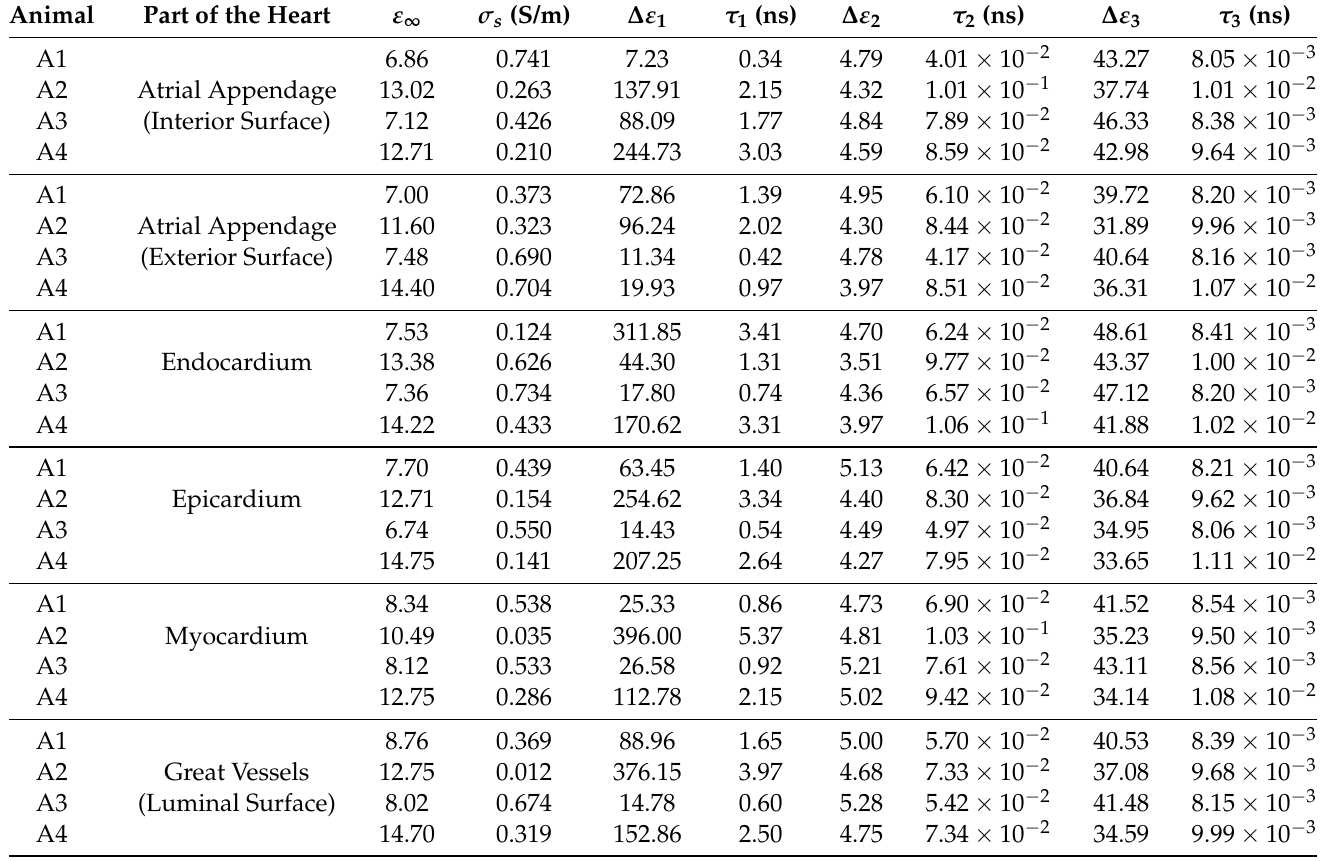
Table 3. Three-pole Debye model parameters fitted to the mean permittivity of measurements on different parts of the heart. Each part was measured on four different hearts and is therefore represented by four sets of Debye model parameters. The model parameters for A1 and A3 are verified at frequencies from 500 MHz to 20 GHz. The parameters for A2 and A4 are verified at frequency range from 500 MHz to 8.5 GHz. These models are suitable for use in broadband numerical simulation scenarios over their respective frequency ranges.